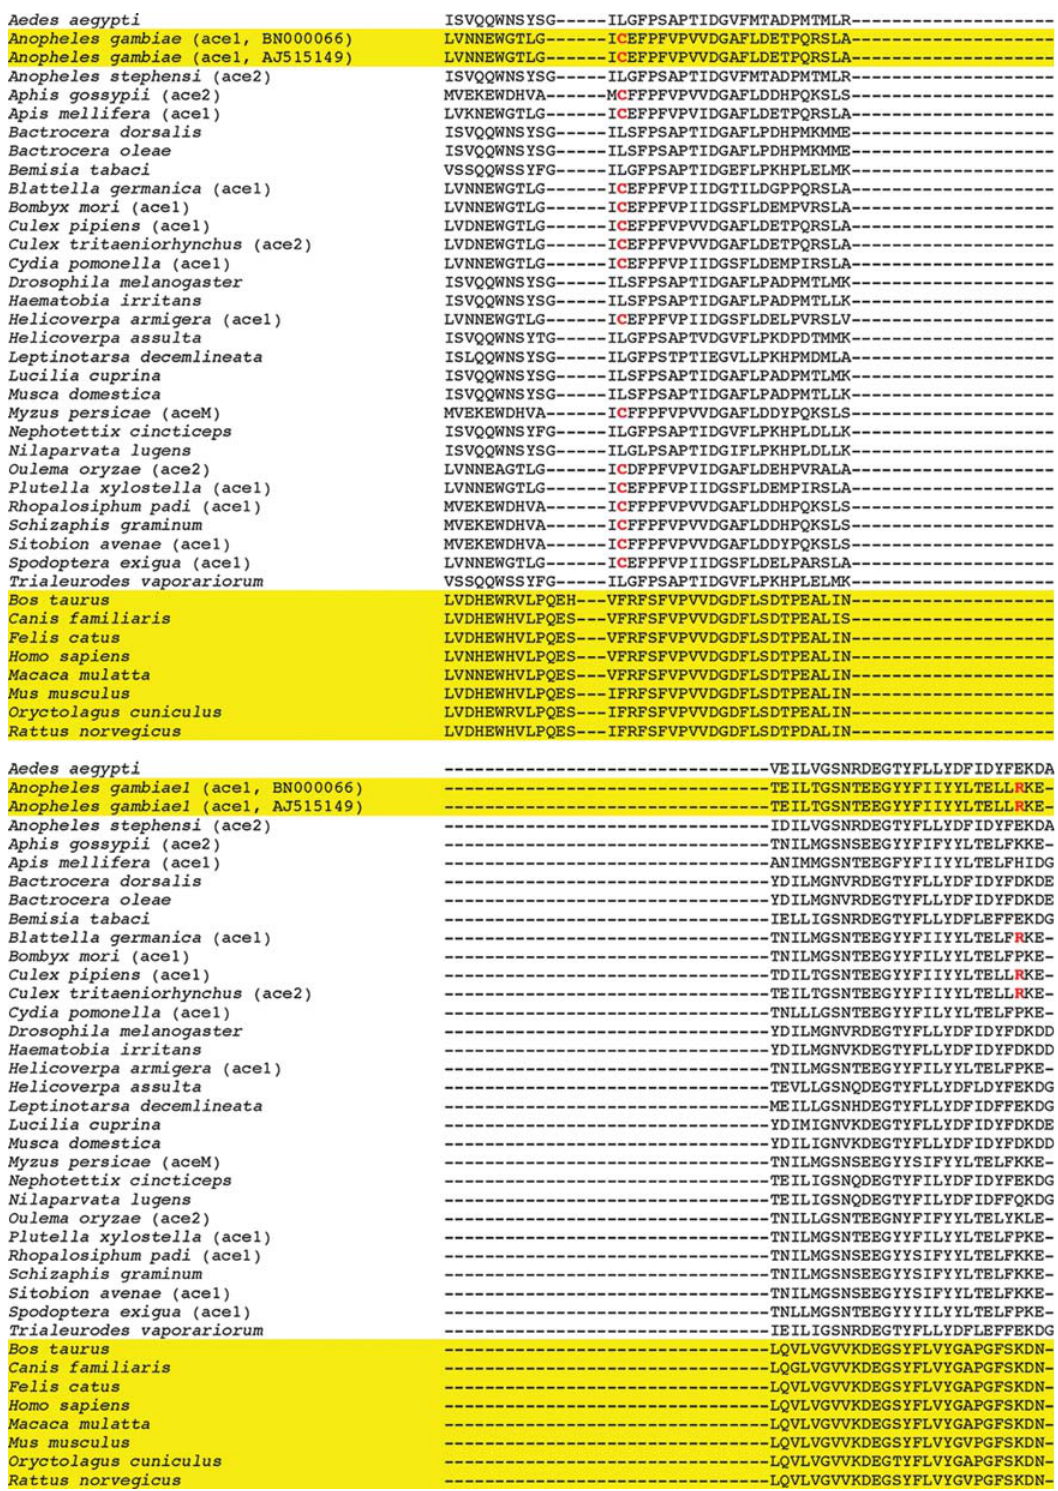
Figure 5. Multiple sequence alignments of acetylcholinesterases of insects and mammals listed in Table 1 . The alignments were generated by CLUSTAL W (1.83). C286 and R339 of Anopheles gambiae acetylcholinesterase (AChE) and the corresponding residues in other species are colored in red. The mammalian and A. gambiae AChEs are highlighted in yellow. The multiple sequence alignments of AChEs of 73 species are shown in Figure S2 of Supporting Information.